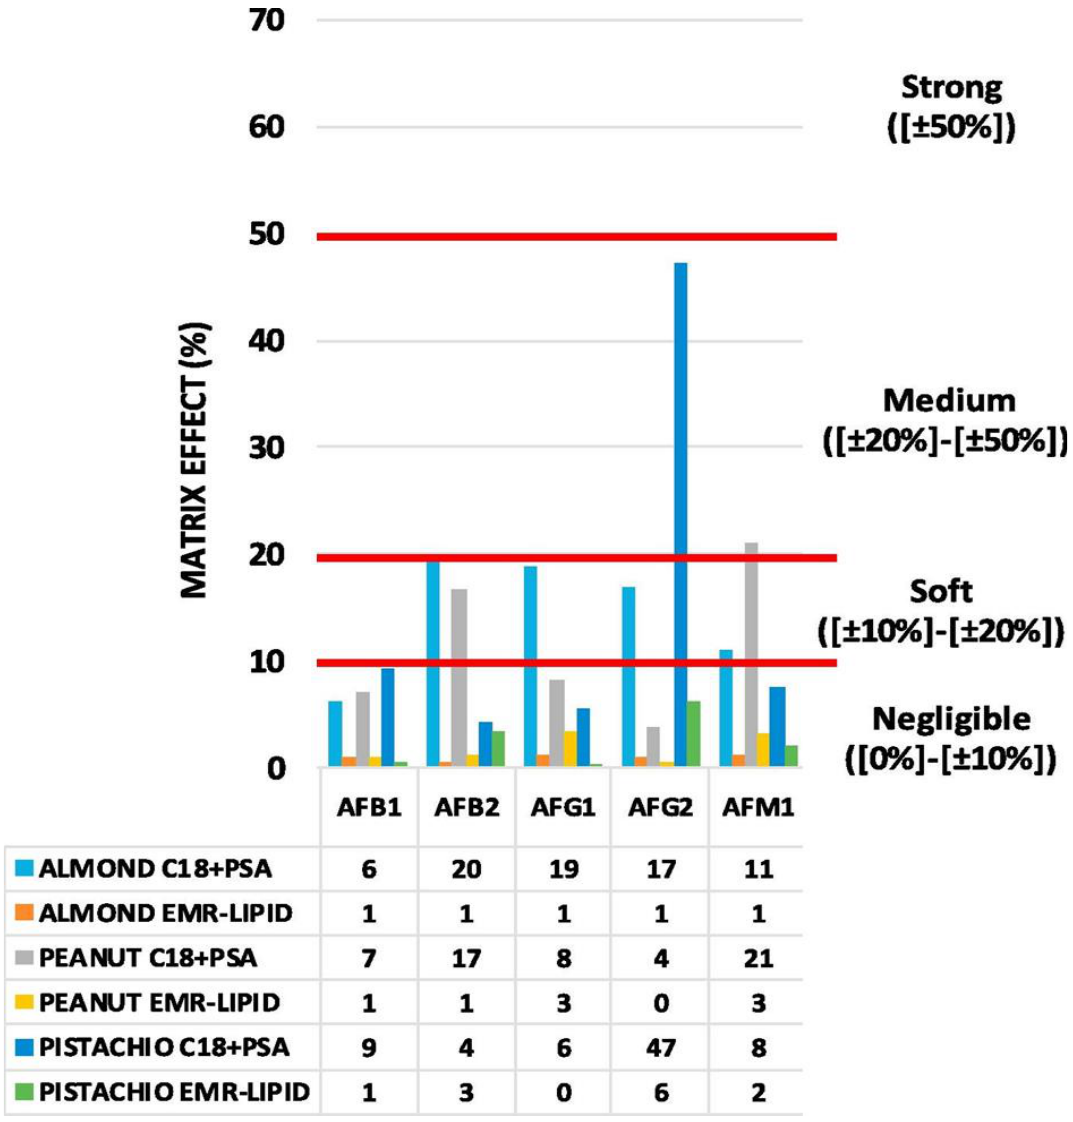
Figure 3. Matrix effects (%) obtained using different dispersive SPE sorbents in each sample studied. Modified and reprinted with the permission of [80].